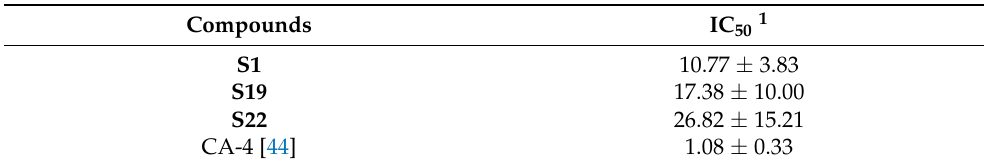
Figure 6. Representative confocal microscopy images of A375 cells after 24 h incubation with compound S1 ( A ), S19 ( B ), S22 ( C ) at concentration of 10 μM, with stained α-tubulin (green) and chromosomes (blue); magnification ×40 plus zoom ×2 during acquisition. Table 3. The IC 50 values ( µ M) of inhibition of tubulin polymerization. Data are expressed as the mean ± SD from at least three independent